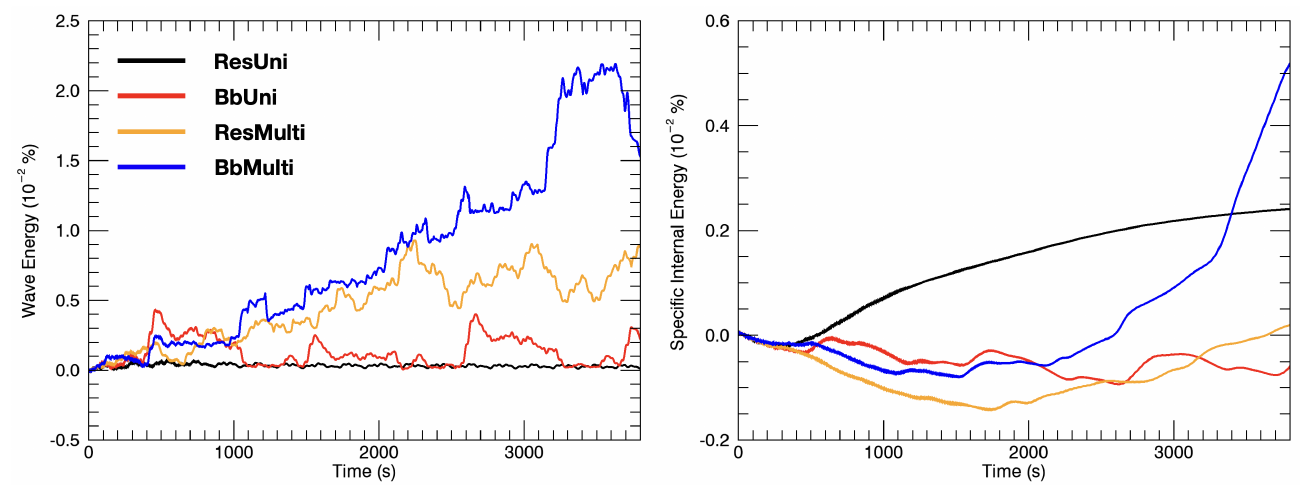
Figure 10. Left : evolution of the volume-integrated wave energy (total perturbed magnetic and kinetic energy). Right : change in the specific internal energy in each of the four cases. The energies are shown relative to the total energy in the initial conditions. See text for